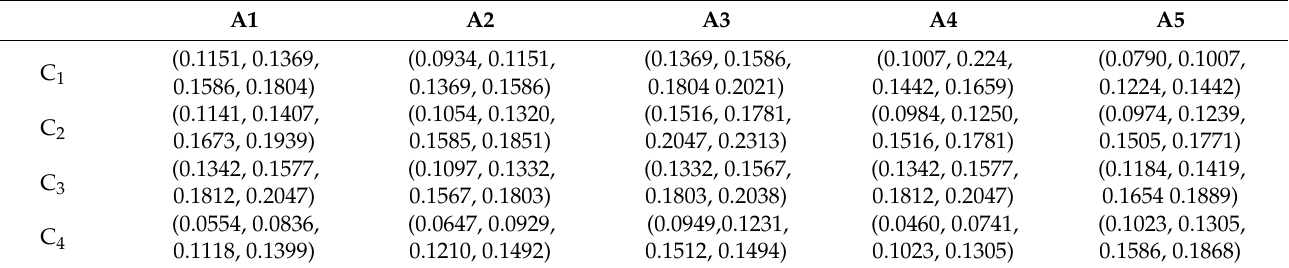
Table 8. Weighted aggregate decision matrix for selecting coal transportation companies.